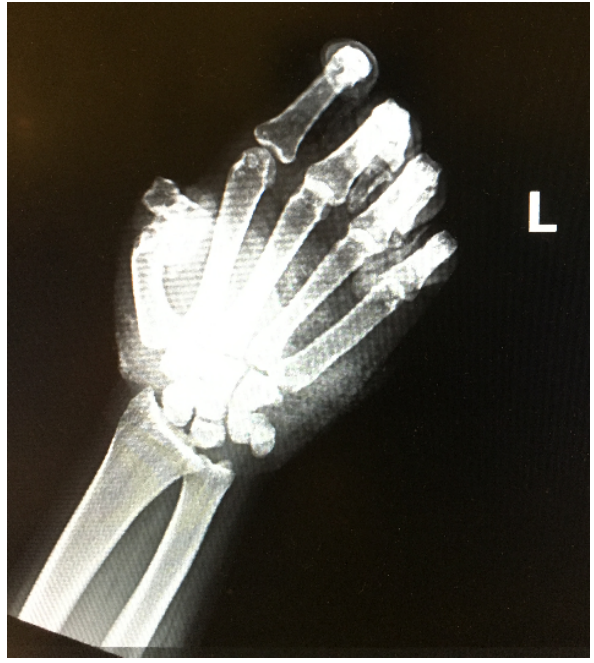
Figure 1: Imaging of hand after loss of distal fingers Surgical exploration of the left eye revealed a 5 mm full- thickness corneal-limbal laceration from the 2:30 to 4:00 o’clock position that was sutured closed. Two clock-hours of iridodialysis were noted after wash-out of the dense hyphema, and the anterior capsule was found to be vio- lated with two dense white bodies noted in the anterior vitreous. A lensectomy and anterior vitrectomy were per- formed with removal of the two foreign bodies, which were then sent to pathology for evaluation. The